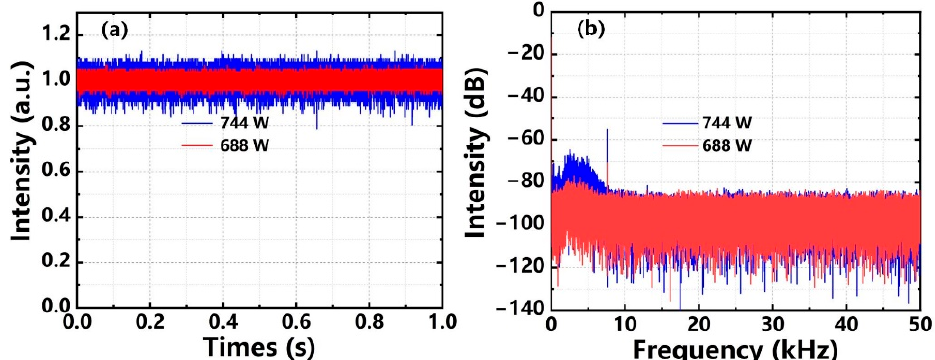
Figure 2. ( a ) Temporal signals of the output laser; ( b ) Corresponding